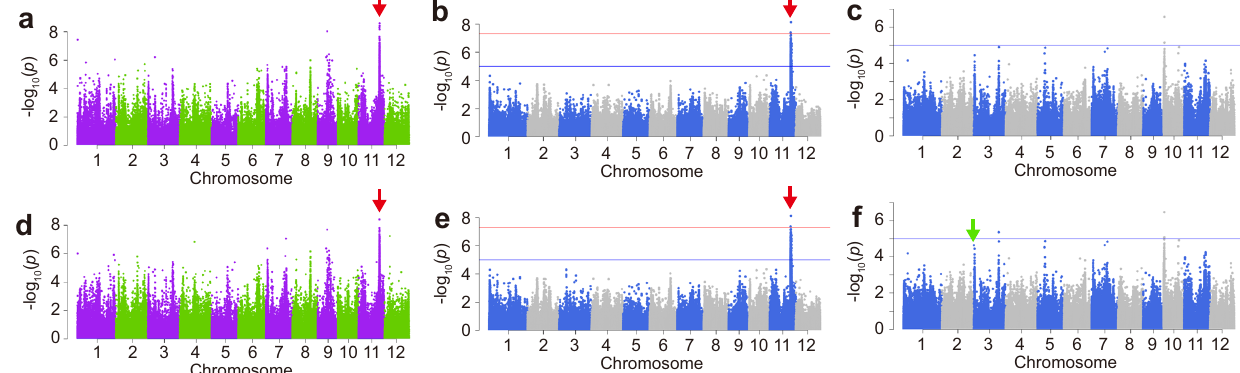
Fig. 1 | Genome-wide association study for rice germination rate. a Genotype × environment(G×E)genome-wideassociationstudy(GWAS)forgerminationrateat 30°Cfor24hvs15°Cfor96h.GWASforgerminationrateat30°Cfor24h( b )and 15°C for 96h ( c ). d G × E GWAS with the modi fi ed variant list. GWAS at 30°C for